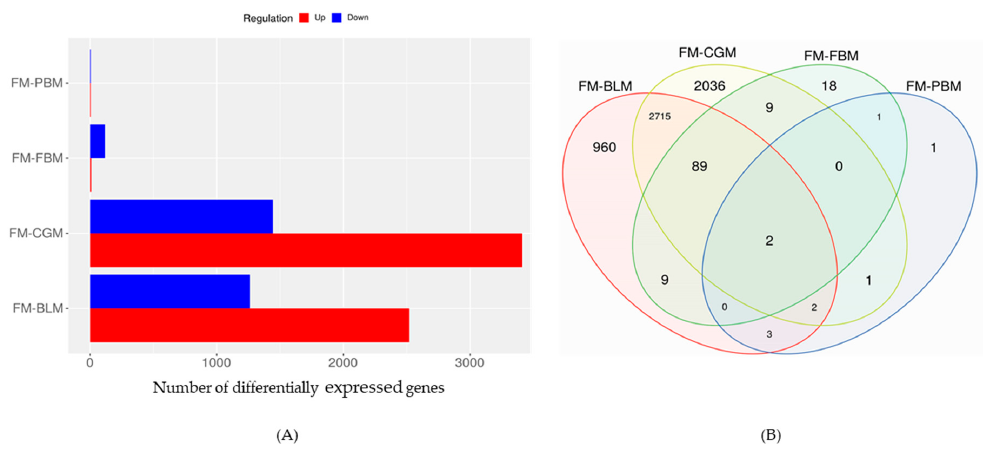
Figure 1. The number of differentially expressed genes (in the distal intestine of sub ‐ adult Yellowtail kingfish fed a diet containing PBM, BLM, FBM or CGM relative to sub ‐ adult YTK fed a diet composed predominantly of prime FM. ( A ) the number of differentially expressed genes between experimental diets and ( B ) Venn diagram showing the number of unique and shared gene cluster in 5 experimental